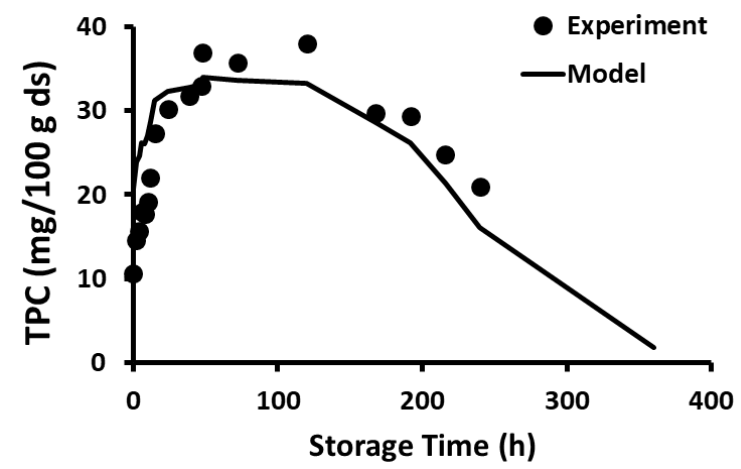
Figure 6. Polyphenol content during storage at 90 °C for 10 days.